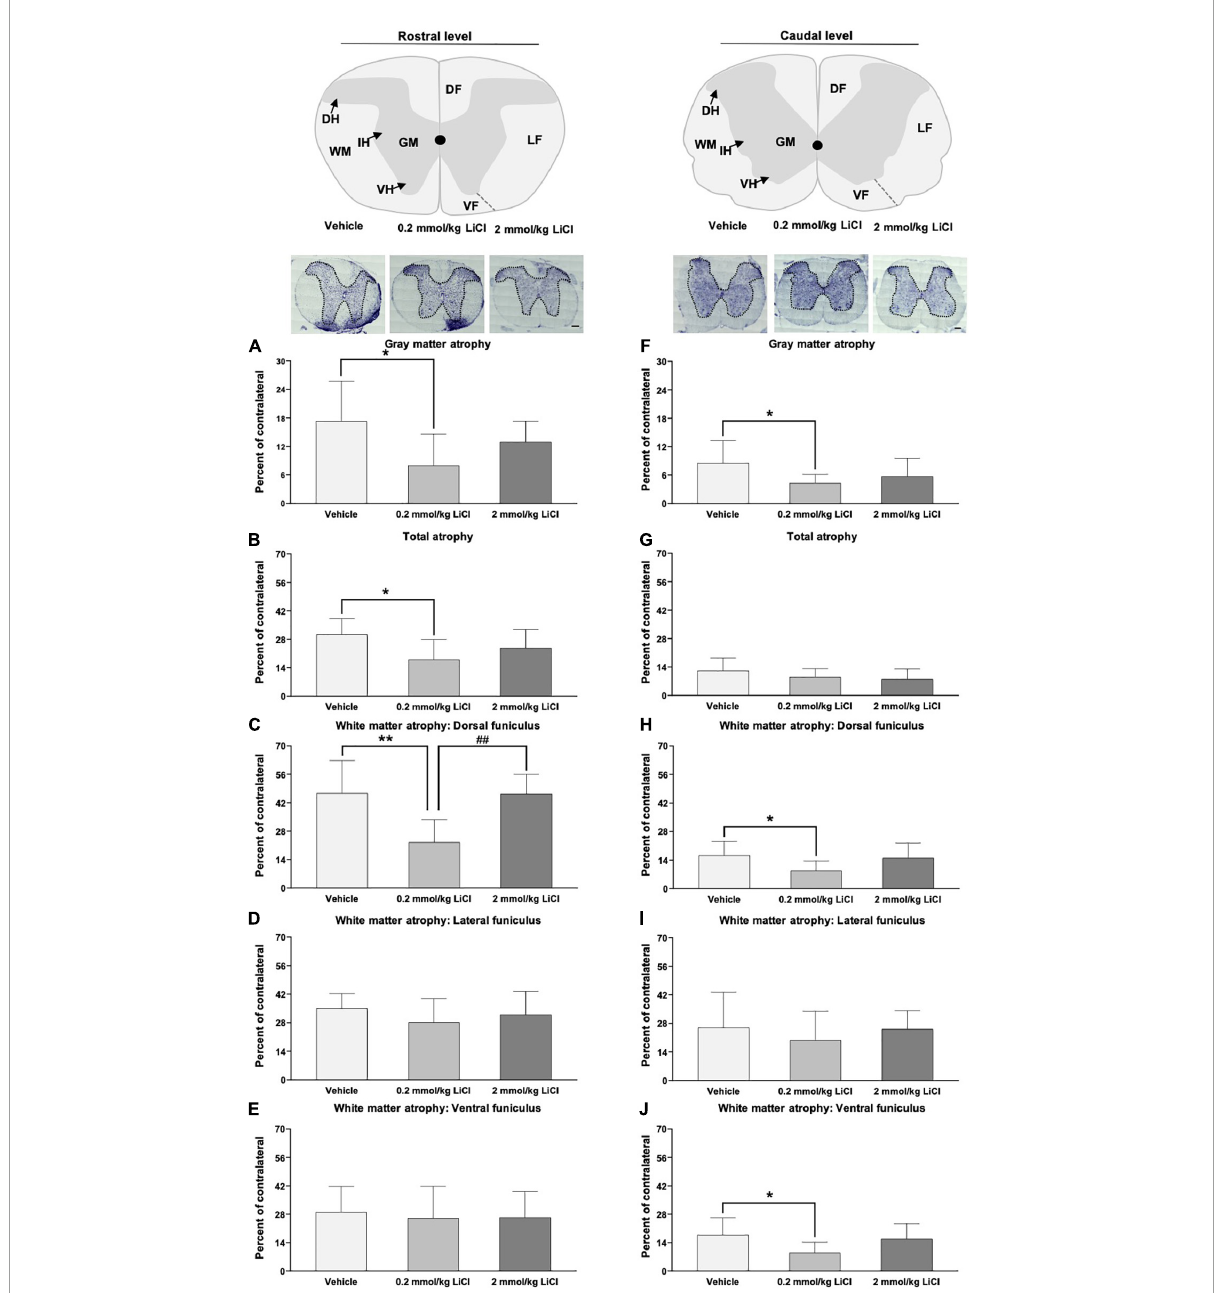
FIGURE3 Low-dose lithium reduces spinal cord atrophy rostral and caudal to the hemitransection. (A,F) Gray matter atrophy, (B,G) total atrophy, (C,H) white matter atrophy of the dorsal funiculus, (D,I) white matter atrophy of the lateral funiculus, and (E) white matter atrophy of the ventral funiculus assessed by Cresyl violet staining at (A–E) the rostrocaudal level above the hemitransection (“Rostral level”) and (F–J) the rostrocaudal level below the hemitransection (“Caudal level”) of SCI mice, which were treated with vehicle or lithium (0.2 or 2 mmol/kg/day) for 56 days. Representative spinal cord sections are also shown. WM, white matter; GM, gray matter; DH, dorsal horn; IH, intermediate horn; VH, ventral horn; DF, dorsal funiculus; LF, lateral funiculus; and VF, ventral funiculus. Data are mean ± SD values ( n = 16 animals/group). * p < 0.05/** p < 0.01 for 0.2 mmol/kg LiCl vs. vehicle; ## p < 0.01 for 0.2 mmol/kg LiCl vs. 2 mmol/kg LiCl. Scale bars, 200 µ m.